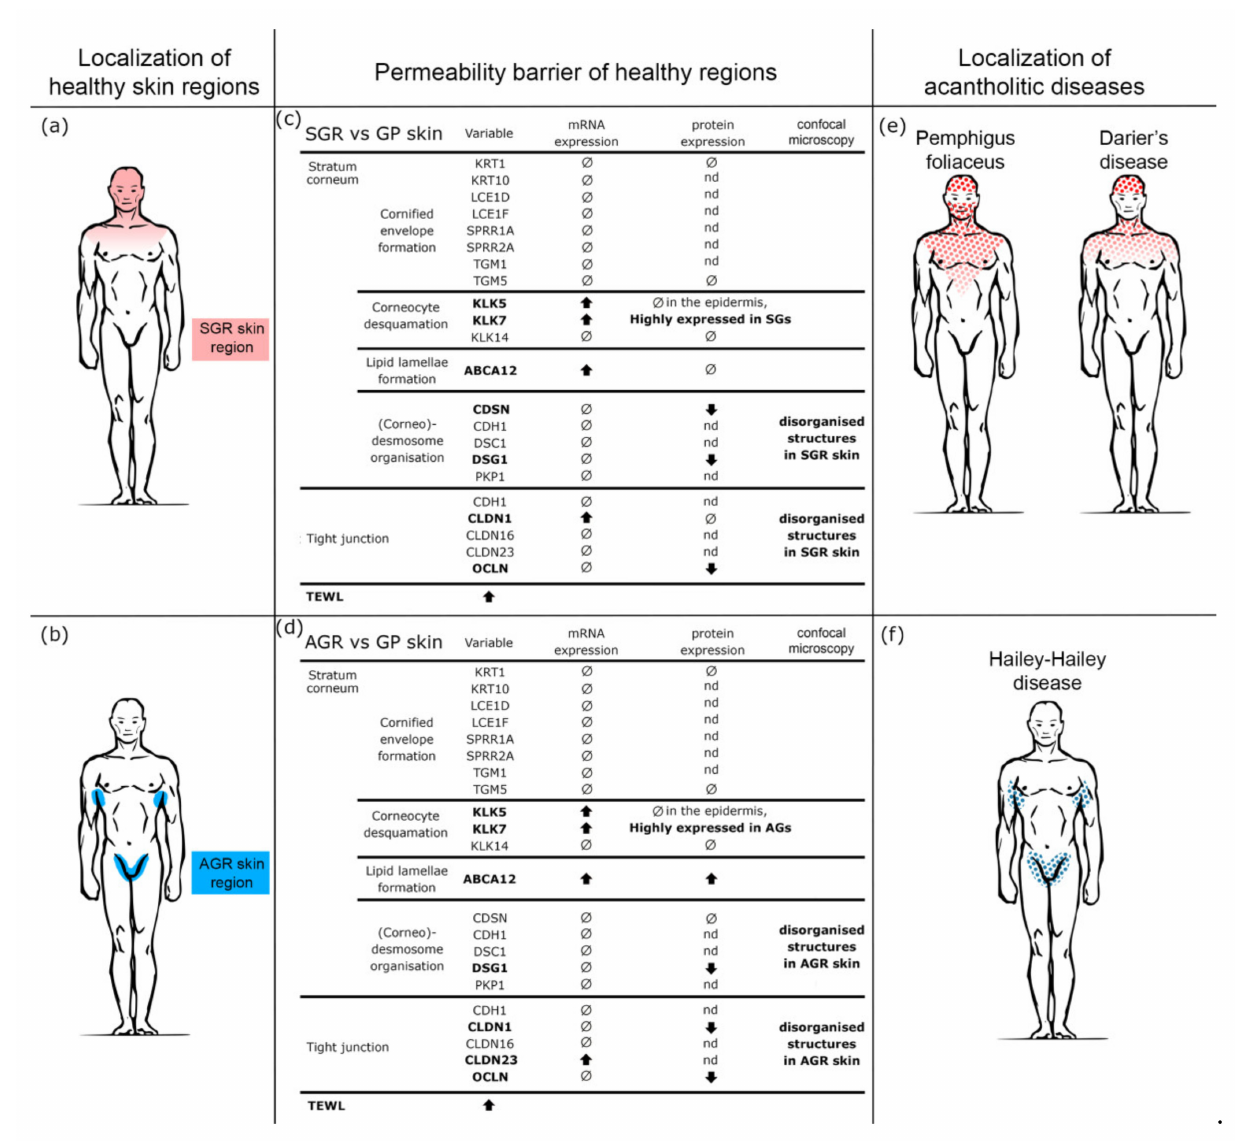
Figure 5. The weakened permeability barrier of SGR and AGR skin regions may explain the characteristic region preference of acantholytic skin diseases. ( a , b ) Based on the distinct chemical milieu, microbiota composition, and immune tuning, three topographically different healthy skin regions can be distinguished, including gland-poor (GP), apocrine gland-rich (AGR), and sebaceous gland-rich (SGR) skin areas. ( c , d ) According to our current findings, permeability barrier-related differences exist in these healthy skin regions. These differences primarily affect cell junctions; expression of protein components and cell membrane organization were significantly lower in SGR and AGR versus GP regions. These differences turned up at the protein rather than mRNA levels, indicating the role of enzymatic degradation in the weakened cell junctions in AGR and SGR areas. These results are in line with the strong KLK5 and KLK7 positivity in these areas. The weakened permeability barrier in AGR and SGR regions was confirmed by TEWL measurements. ( e , f ) The results of our study explain the well-known but unexplained clinical observations that some acantholytic skin disorders have preferred localization. Pemphigus foliaceus (PF) develops first in SGR, while Darier’s disease (DD) and Hailey–Hailey disease (HHD) mainly develop their main signs in SGR and AGR skin regions. Our present data indicate that these skin regions have weakened permeability barriers under steady-state and are the weak links of our